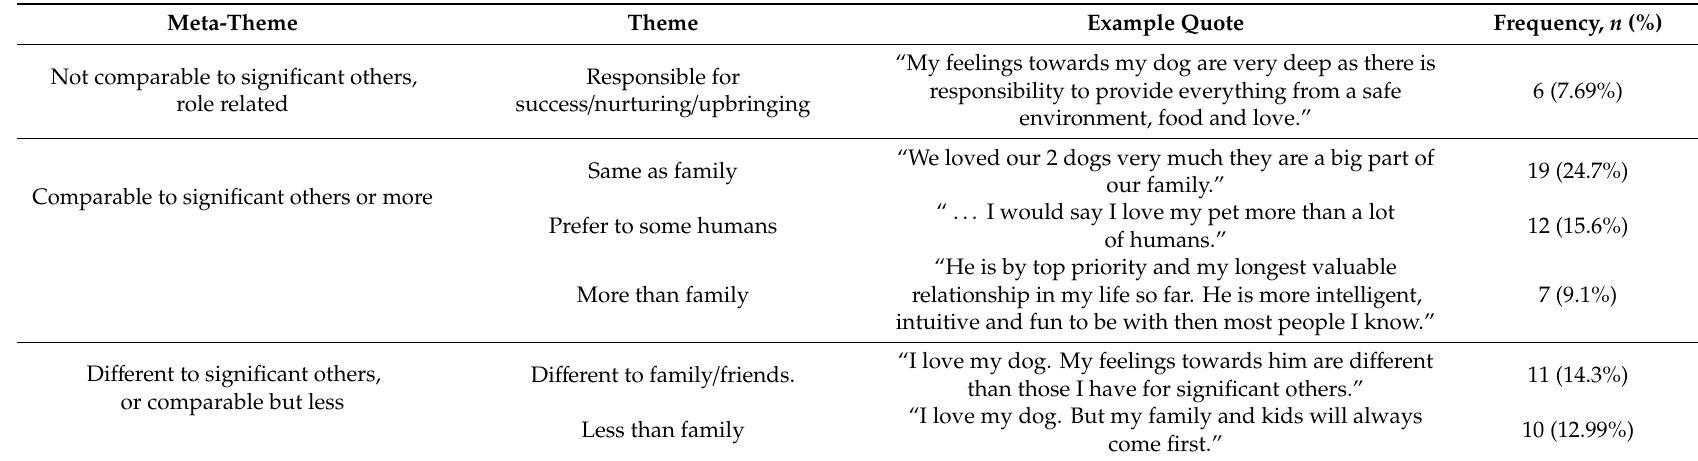
Table 12. CDO descriptions of their feelings towards dog compared towards significant others ( n =